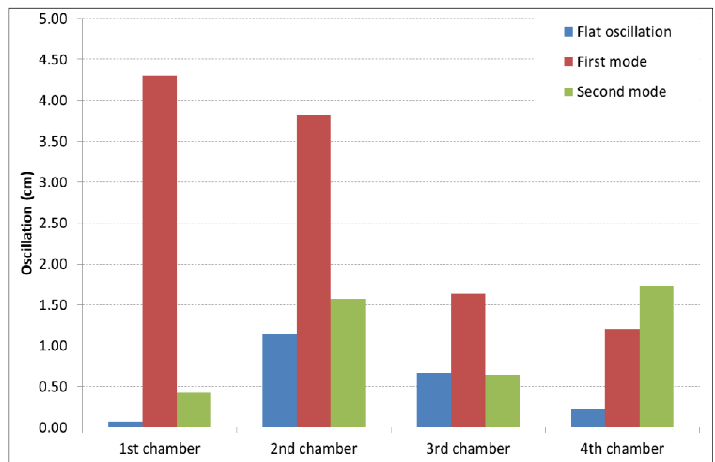
Figure 12. Height of the oscillation within the four chambers, for a regular wave test with H = 6 cm and T = 0.7 s ( i.e ., the period inducing the 1st mode